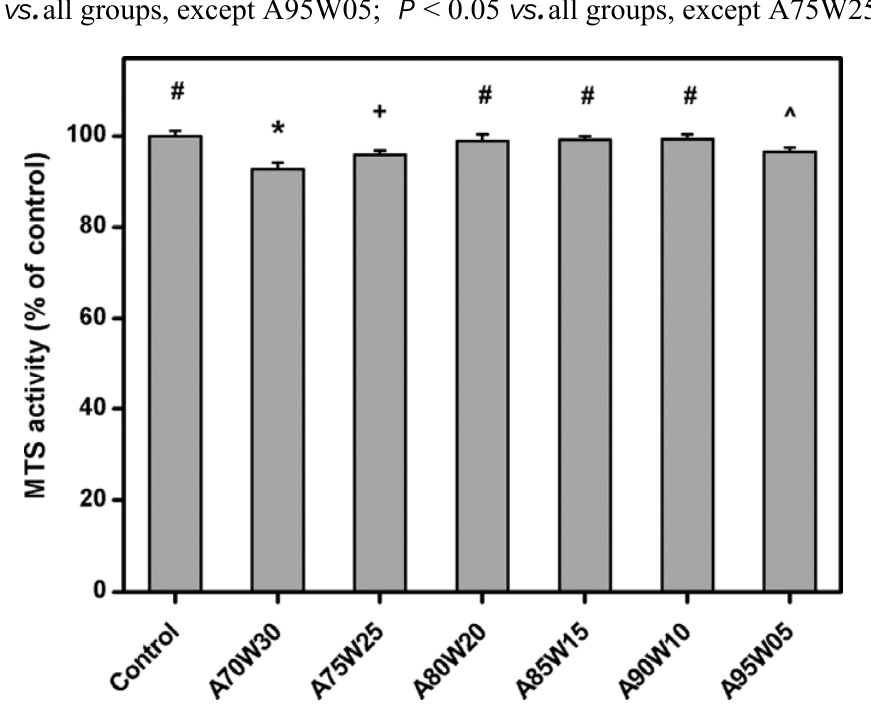
Figure 7. Cell proliferation assay of ARPE-19 cultures incubated for three days at 37 °C with various EDC cross-linked HA membranes. Results are expressed as percentage of controls (MTS activity of cells cultured in the absence of materials). Values are mean ± SD ( n = 5). * P < 0.05 vs. all groups; # P < 0.05 vs. A70W30, A75W25, and A95W05